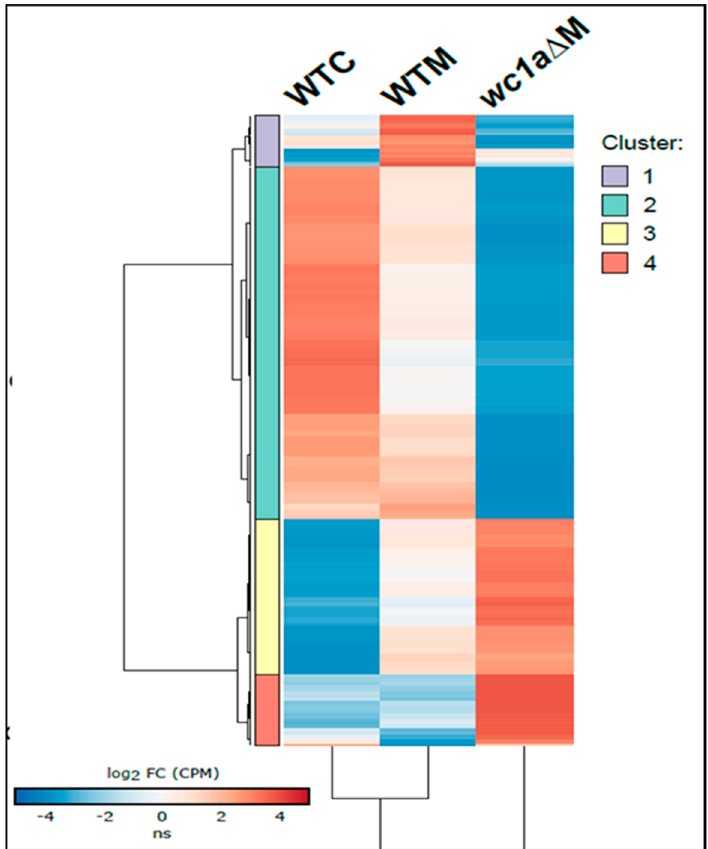
Figure 4. The expression values (calculated as the Z-score of CPM) of significant genes during macrophage phagocytosis are clustered by similarity to analyze phagocytosis response in the mcwc-1a Δ mutant. Expression values for wild-type strain in control conditions (WTC) and during macrophage phagocytosis (WTM), as well as for the mcwc-1a Δ during macrophage phagocytosis ( wc1a ∆ M), are shown. Four major clusters were identified and shown as colored blocks that indicate the full length of the clusters.